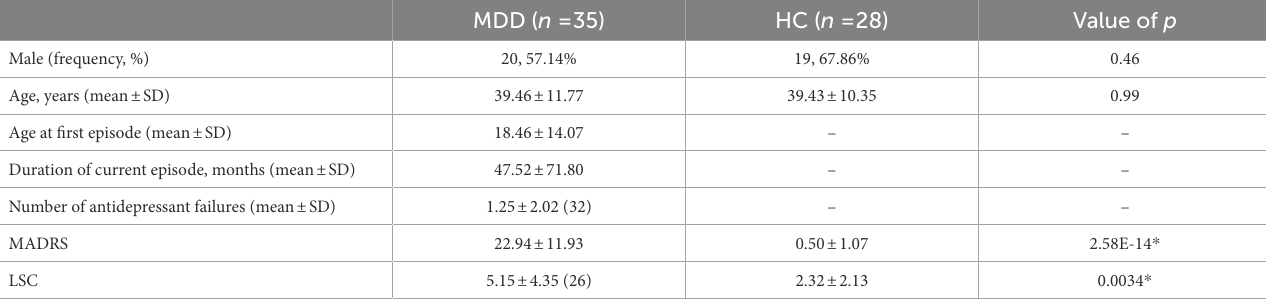
TABLE 1 Demographic and clinical